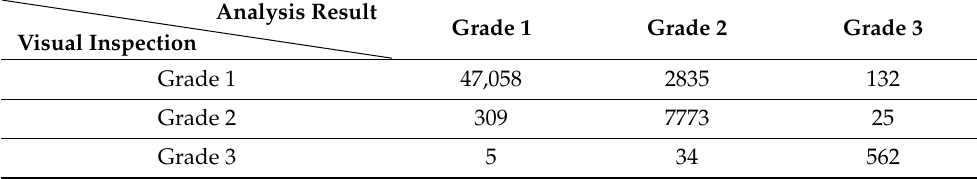
Table 3. A confusion matrix with three